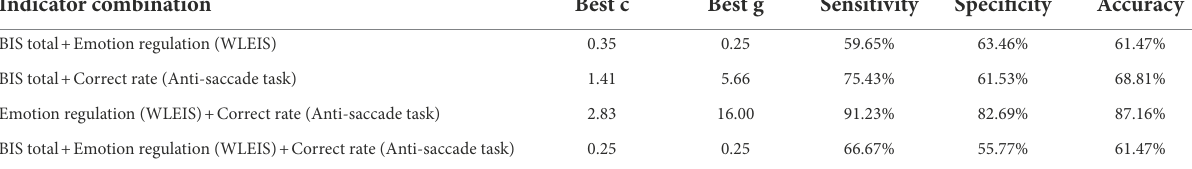
TABLE 4 Discriminating HIGD from LIGD by SVM